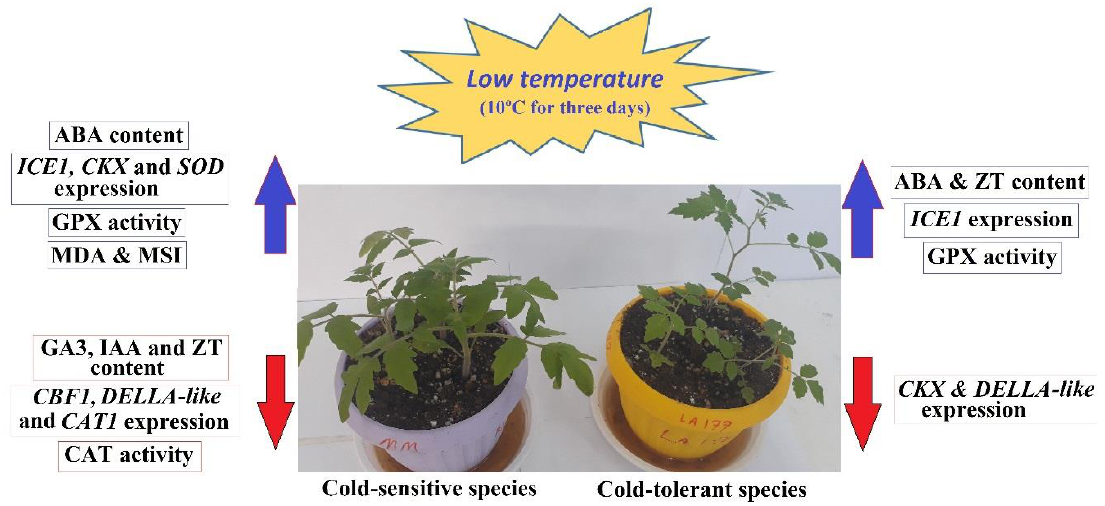
Figure 5. Effects of low temperature on hormone contents, antioxidant activity, and gene expression in tomato species. The red arrows indicate decreasing characteristics, and the blue arrows indicate increasing characteristics.